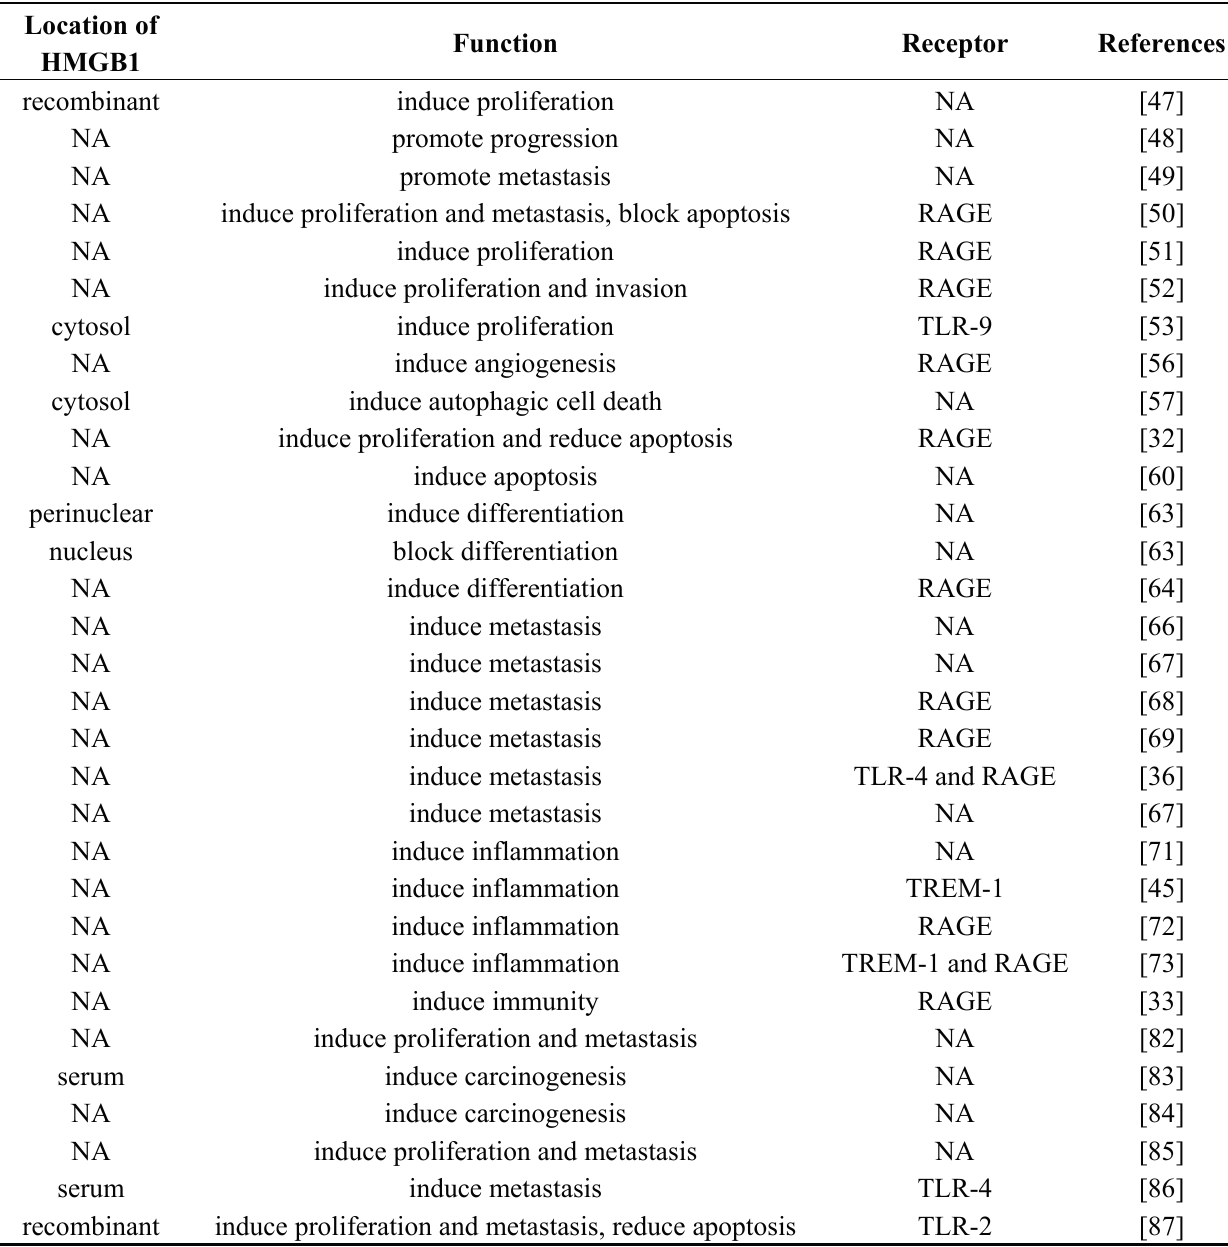
Table 1. HMGB1 and its roles in